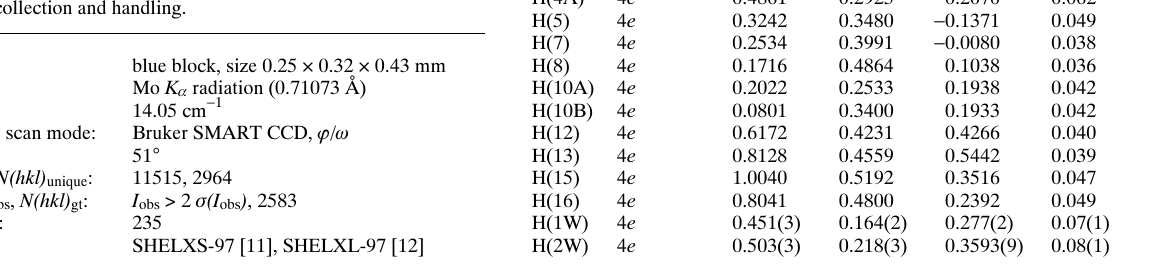
Table 1. Data collection and